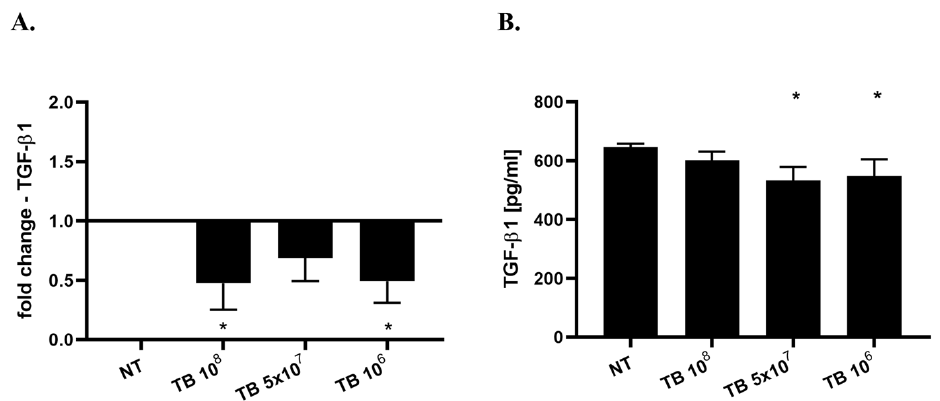
Figure 7. Effect of TB on the gene expression and release of TGF- β 1 by THP-1-derived macrophages. THP-1-derived macrophages were incubated for 4 h with different concentrations of TB and the effect on the gene expression and protein release of TGF- β 1 was assessed by Real Time PCR ( A ) and ELISA/( B ), respectively. Data are expressed as mean ± SD (N = 4). For statistical analysis, repeated measures ANOVA with Bonferroni post hoc test was applied. * p < 0.05 vs. NT.